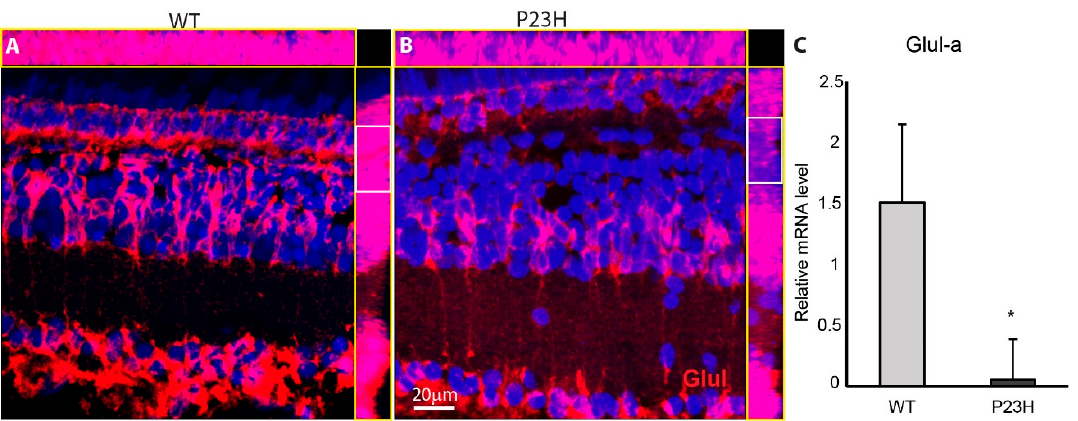
Figure 8. Glutamine synthetase (Glul) immunostaining is weak in the P23H transgenic fish. ( A , B ) Immunolabeling for Glul (red) shows the overall intensity of Glul is weak in the P23H compared to WT. The top and side yellow boxes on each panel show the and X and Y maximum intensity orthogonal projections, respectively. Glul immunostaining is much weaker in the OPL and outer ONL of P23H transgenic compared to the WT (highlighted in white box). ( C ) Relative mRNA level of Glul-a is higher in the WT compared to the P23H ( n = 3 fish per genotype; error bars are ± SD; * p < 0.05).